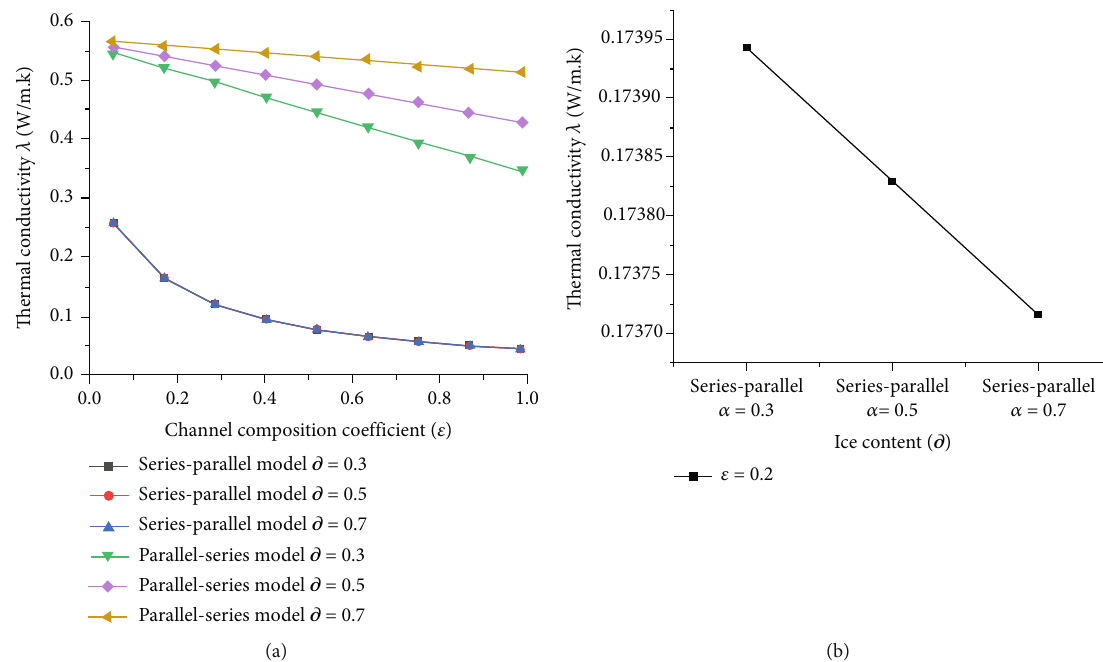
Figure 21: Relationship between thermal conductivity λ and channel composition coe ffi cient ε of integrated REV model with di ff erent ice content ∂